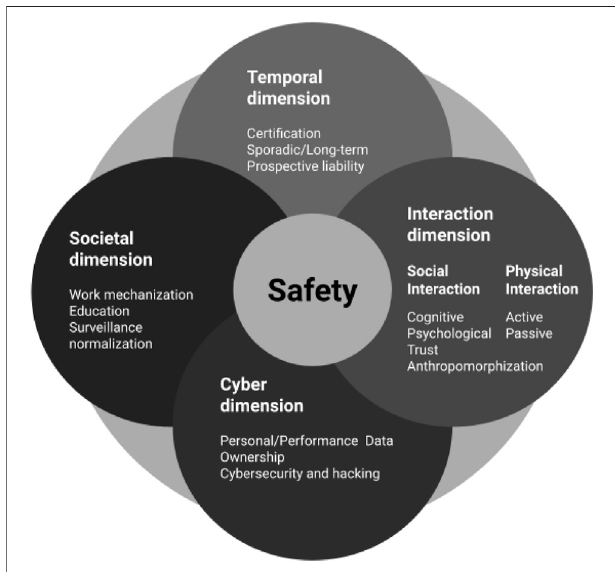
FIGURE 3 | The different dimensions of safety in light of robots and